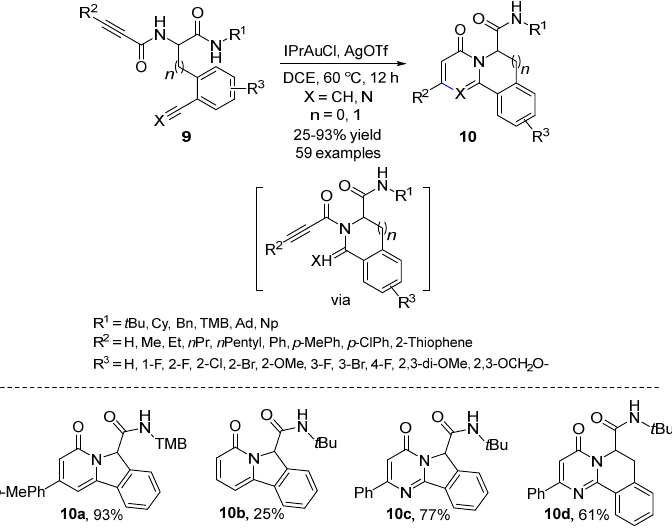
Scheme 6. Gold ‐ catalyzed hydroamination/cycloisomerization. Scheme 6. Gold-catalyzed